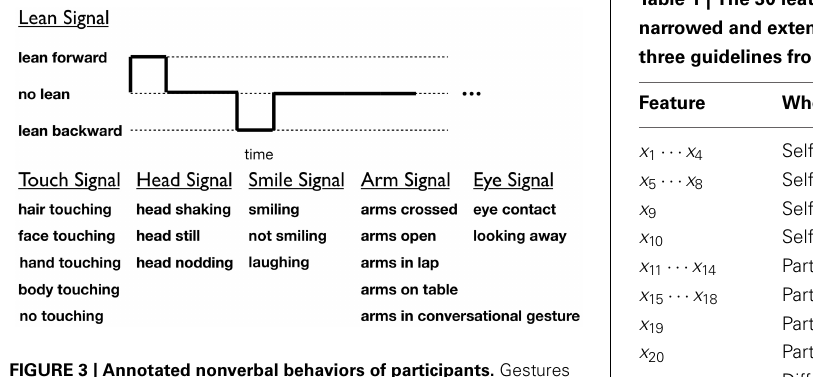
FIGURE 3 | Annotated nonverbal behaviors of participants. Gestures within a category are mutually